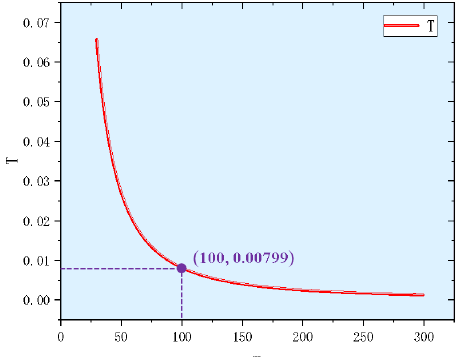
Figure 4. Graph of the variation of T with m.